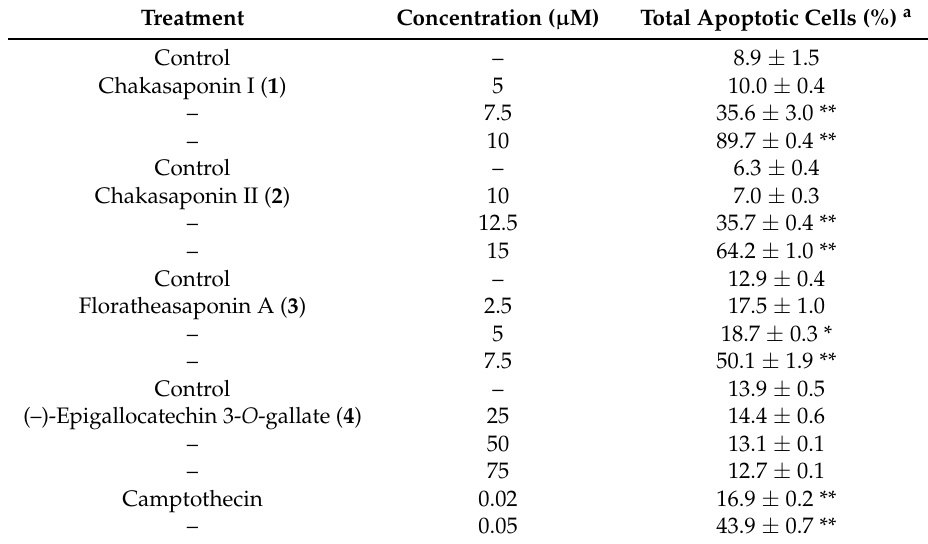
Table 3. Effects of 1 – 4 and camptothecin on the apoptosis of HSC-2 cells for 24 h. Treatment